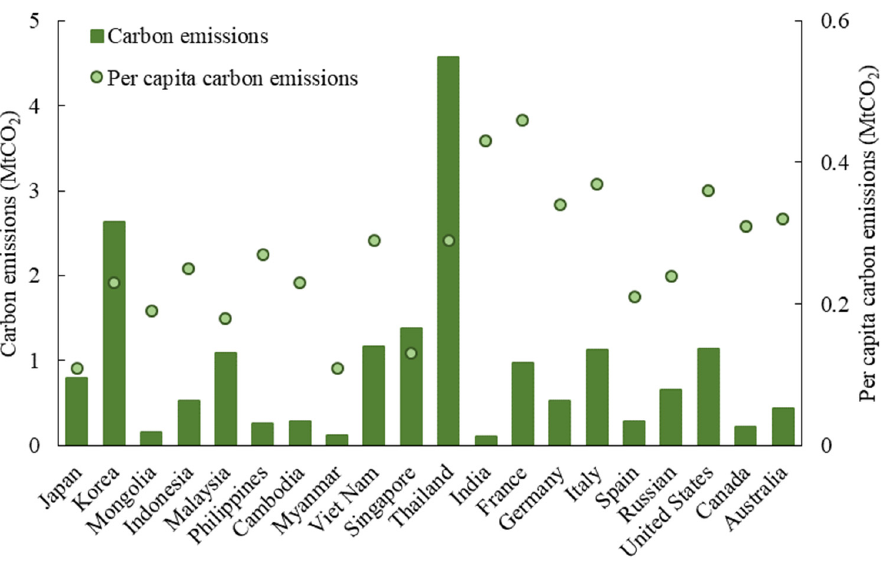
Figure 5. The receiving system carbon emissions of China’s outbound tourism in 2015 (20 main countries are shown).